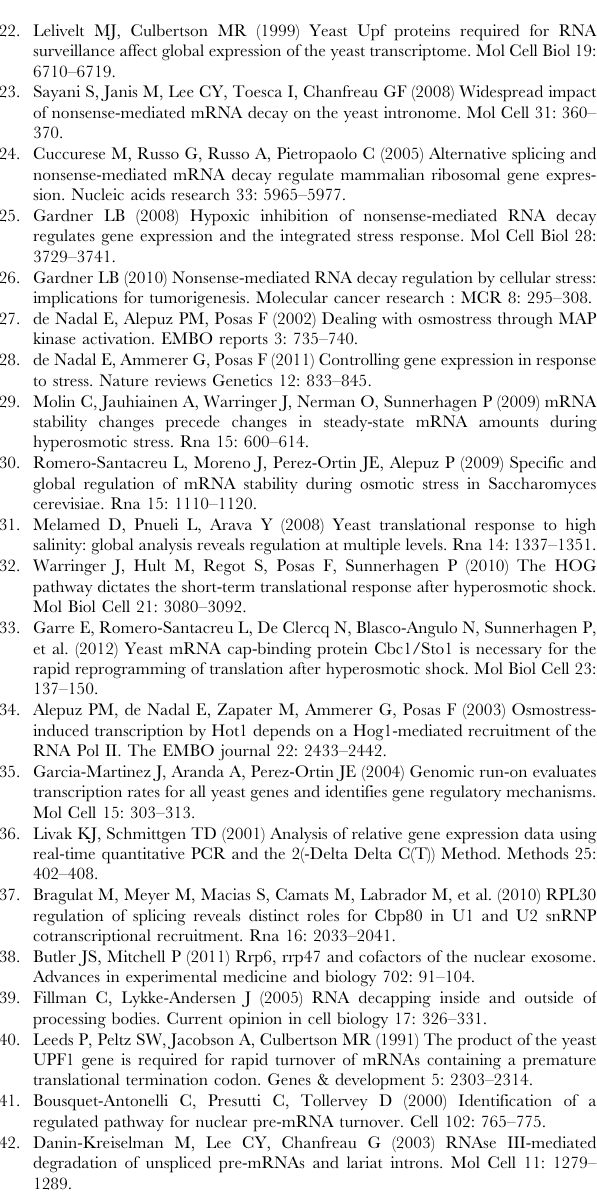
Table S1 Primers used in this work. Table S2 PM index list calculated using the exons and introns intensity signals after 15 min of osmotic stress (0.4 M NaCl) relative to non-stress conditions obtained from tiling